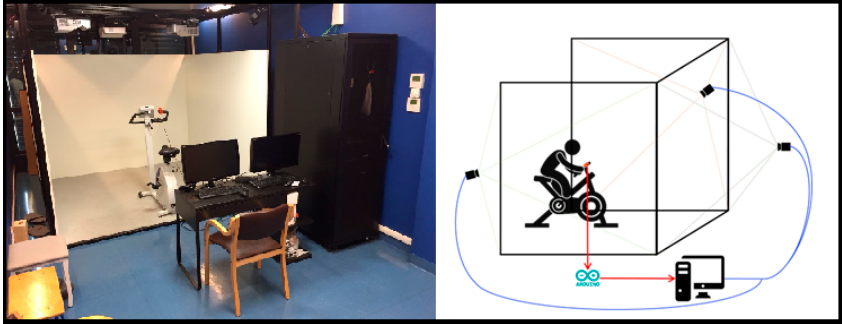
Figure 1. A picture of a real set up and a schematic representation of the hardware setup.